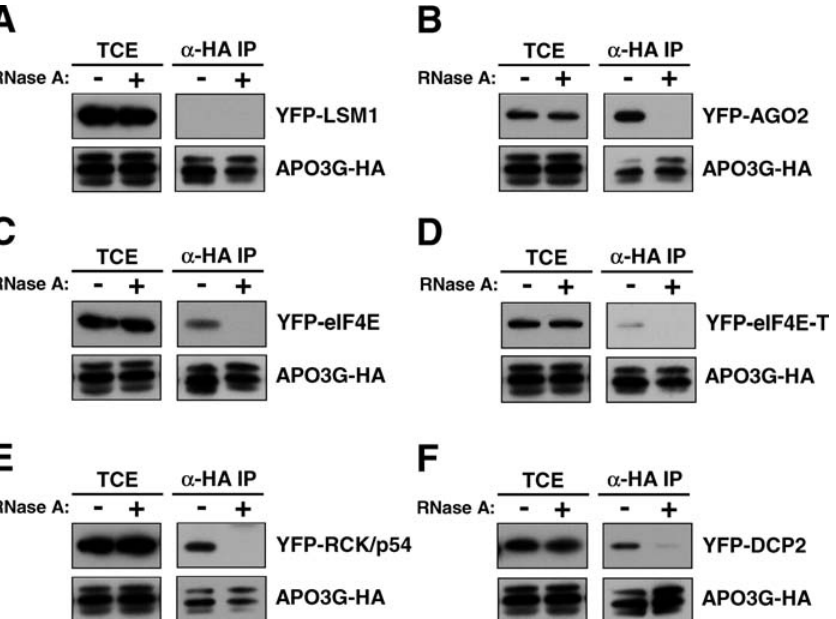
Figure 3. APOBEC3G Interacts with P-Body Proteins through RNA-Dependent Interactions Total cell extracts from 293T cells coexpressing APO3G-HA and YFP-LSM1, YFP-AGO2, YFP-eIF4E, YFP-eIF4E-T, YFP-RCK/p54, or YFP-DCP2 (A–F, respectively) were treated with RNase A ( þ ) or vehicle alone ( (cid:1) ) and APO3G-HA was immunoprecipitated (IP) with a -HA agarose ( a -HA IP). Total cell extracts (TCE) and a -HA IPs were analyzed by immunoblot, and APO3G-HA was detected with an antibody against the HA epitope, while YFP-tagged P- body proteins were detected with an antibody against GFP. DOI: